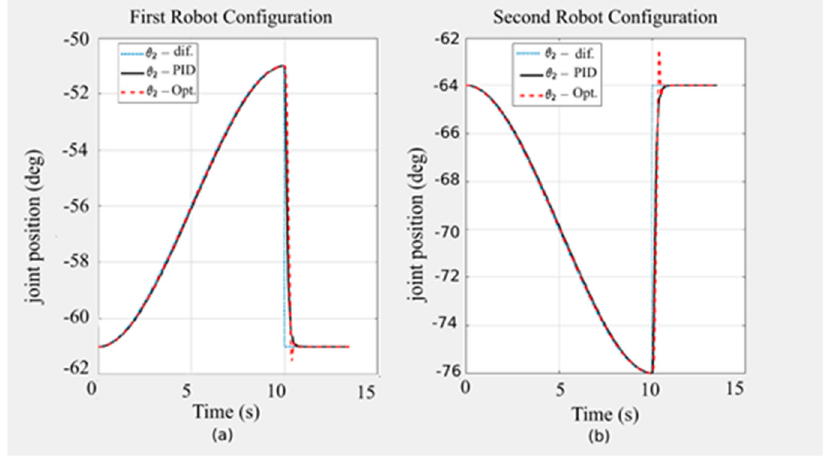
Figure 10. Step response of the UR5 robot for the two configurations of Joint 3.